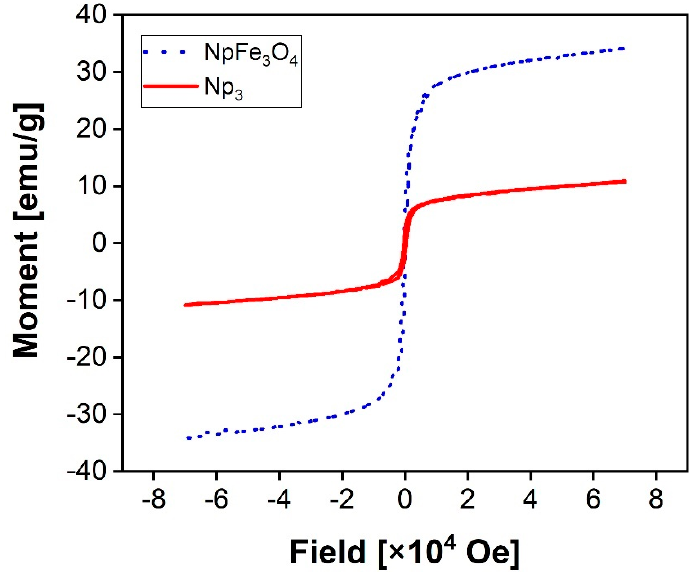
Figure 4. The magnetic curve of NpFe 3 O 4 and Np 3 at 300 K. The hysteresis loops were obtained with a maximum field of 7 × 10 4 Oe. The samples were previously lyophilized.